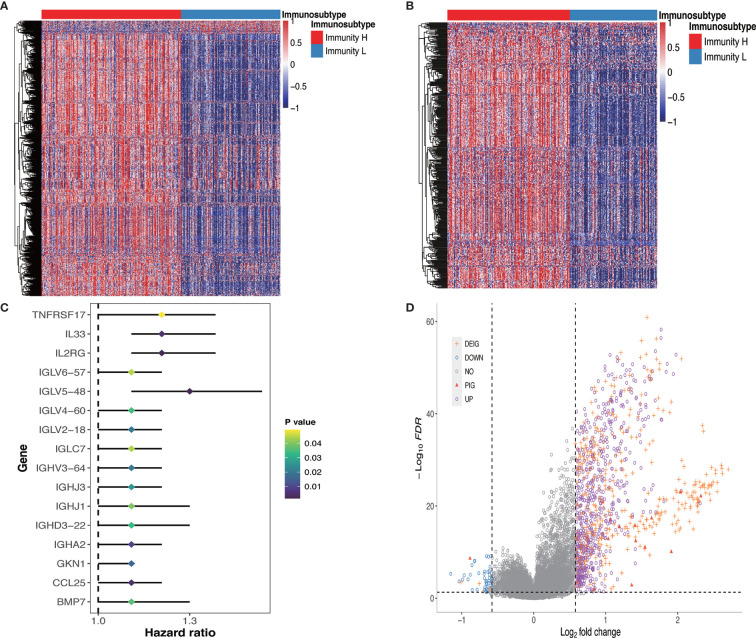
DEGs, DEIGs, and PIGs expression and their prognostic value analysis. (A) Landscape of all DEGs between two subtypes. (B) Landscape of all DEIGs between two subtypes. (C) Forest plot based on univariable Cox proportional hazards regression analysis shows the PIGs and their hazard ratios. (D) Volcano plot of all DEGs, DEIGs, and PIGs shows the log2 (fold change) and FDR value of each gene. Differentially expressed genes to be exhibited in heatmap graph with |fold change| >1.5 and FDR<0.05. DEG, differentially expressed gene; DEIG, differentially expressed immunity gene; PIG, prognosis-associated immunity gene.